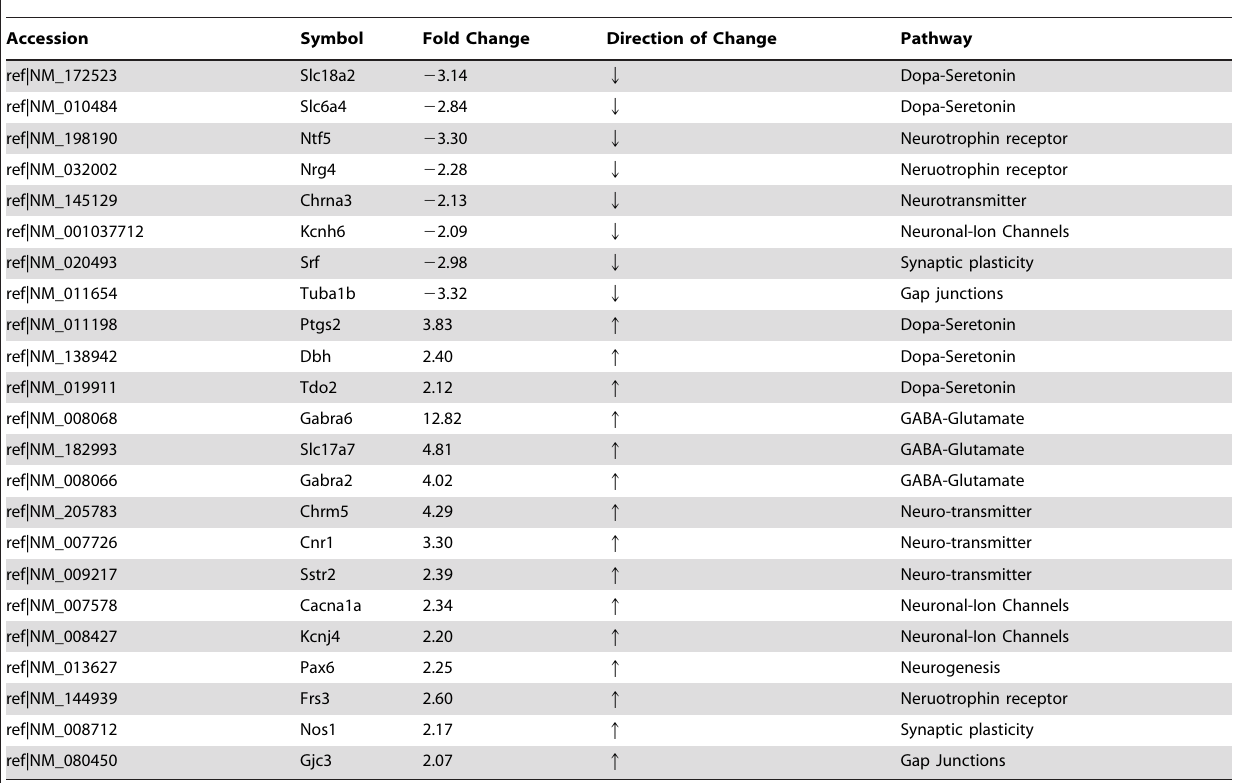
Table 2. Neural genes altered $ 2 fold in the cerebral hemisphere of female pups from mothers having FA supplementation during gestation at 4 mg/kg in comparison to mothers at 0.4 mg/kg